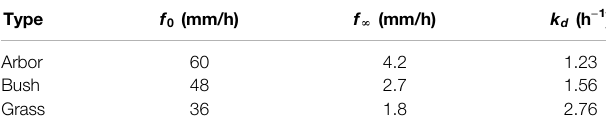
TABLE 1 | In fi ltration parameters of different